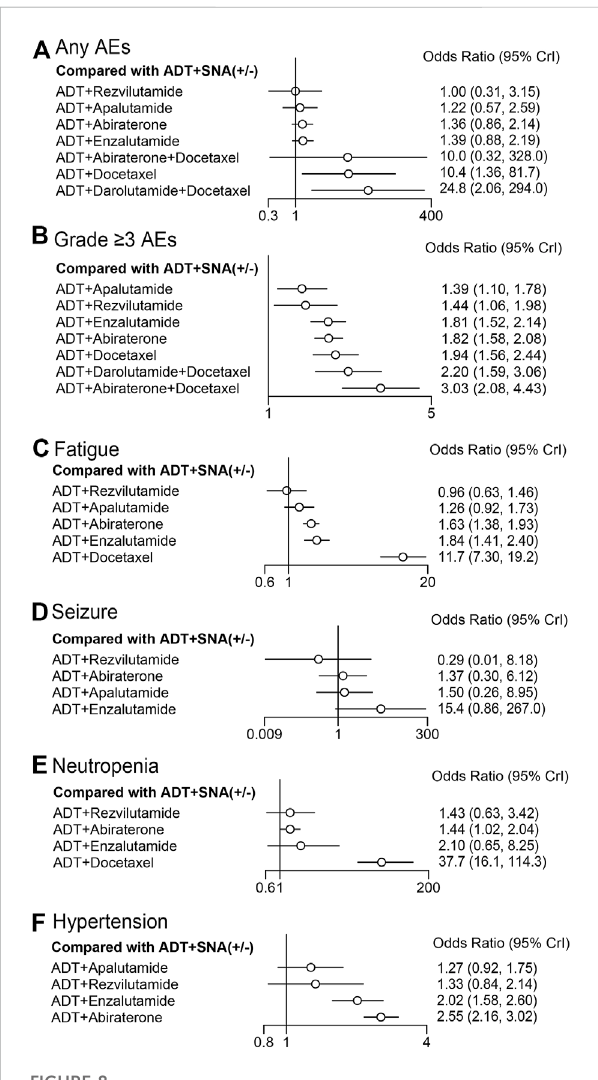
FIGURE 8 Forest plot representing a comparison of adverse events for speci fi ctherapycomparedwithADTwithorwithoutSNA.ORand95% CrI are represented. (A) Any AEs; (B) grade ≥ 3 AEs; (C) fatigue; (D) seizure; (E) neutropenia; (F) hypertension. ADT, androgen deprivation therapy; SNA, standard non-steroidal antiandrogen; AEs, adverse events; OR, odds